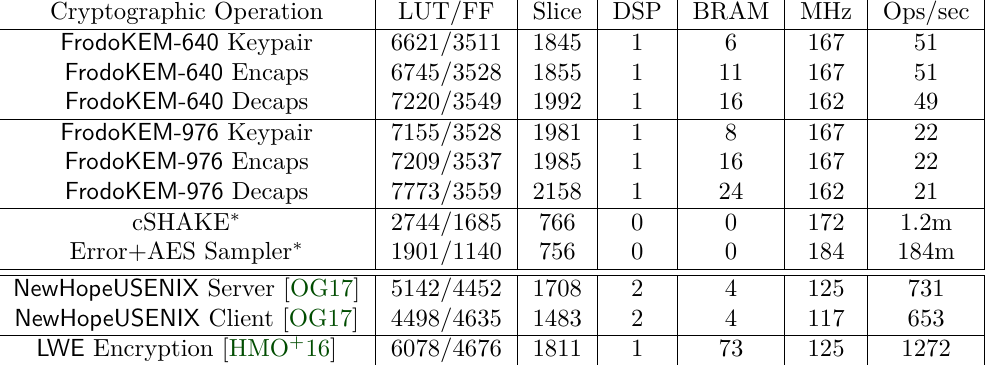
Table 3: FPGA resource consumption of the proposed FrodoKEM-cSHAKE hardware design, with its sub-modules ( ∗ ), alongside NewHopeUSENIX-1024 [OG17] and Standard-LWE encryption [HMO + 16] hardware designs for comparison. FrodoKEM and NewHopeUSENIX- 1024 utilize a Xilinx Artix-7 FPGA and Standard-LWE utilizes a Xilinx Spartan-6 FPGA.